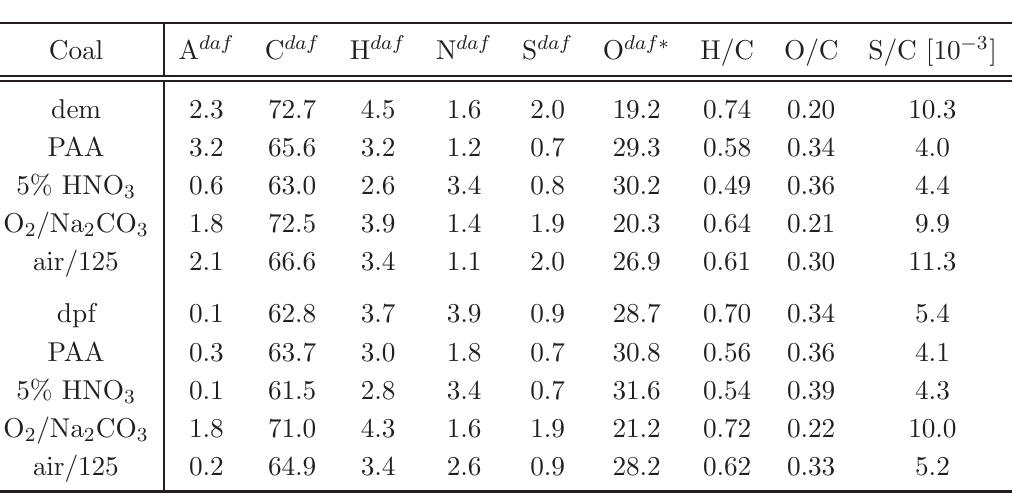
Table 4 Results of the elemental analysis of the solid products of extraction with CH 2 Cl 2 [wt %] and molar ratios of H/C, O/C and